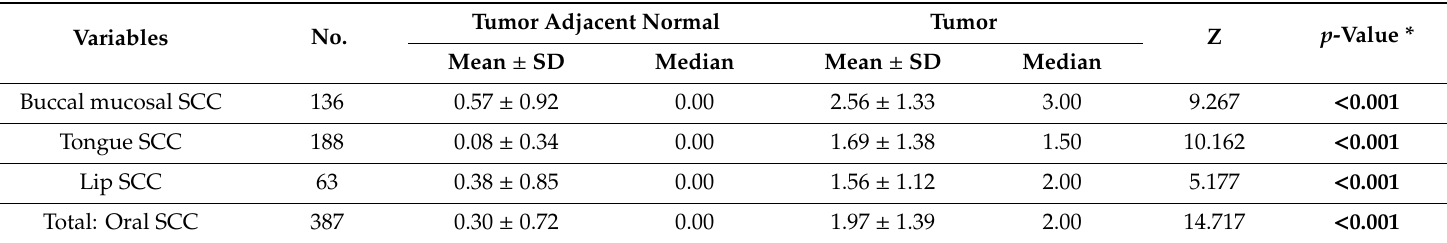
Table 1. Comparison of UBE2C expression between corresponding tumor adjacent normal tissues and tumor tissues in three primary subsites of OSCC patients. Variables No.